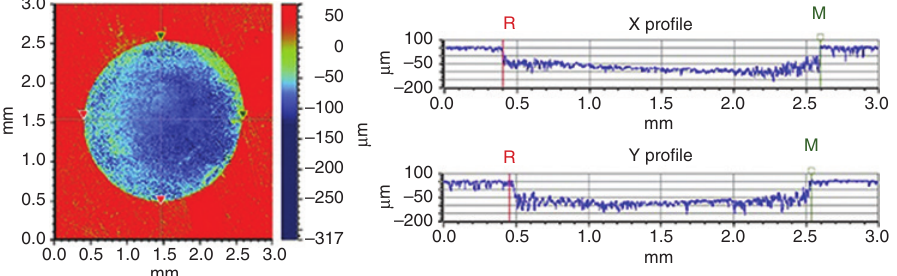
Figure 3: 2D analysis example of the Filtek Supreme composite material.